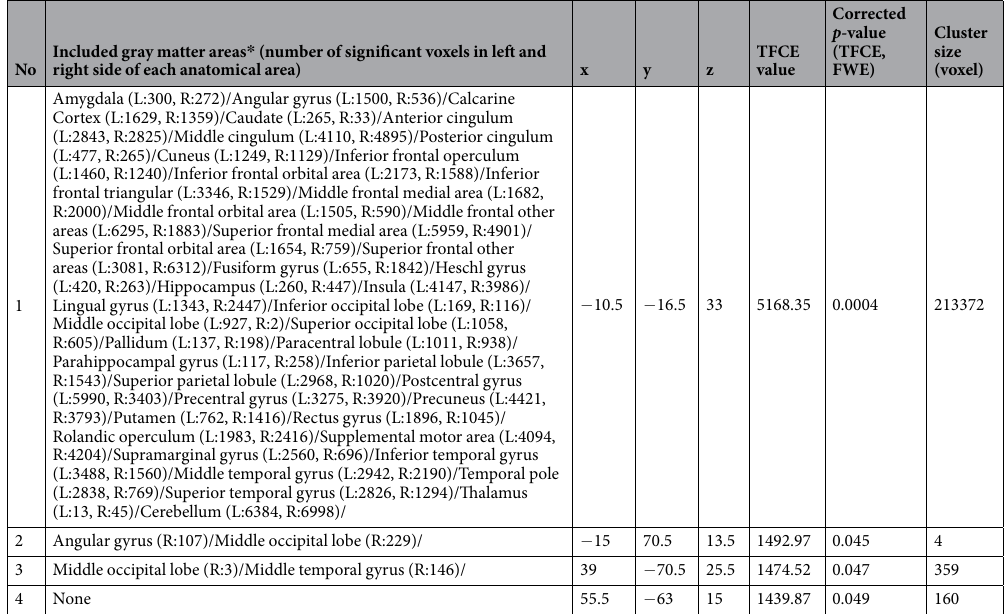
Included gray matter areas * (number of significant voxels in left and No right side of each anatomical area)